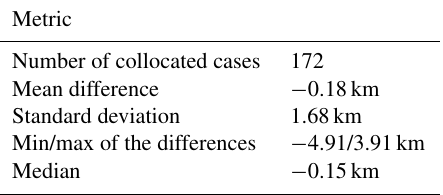
Table 4. Statistical metrics from the validation between GOME-2 AAH and EARLINET retrieved aerosol layer